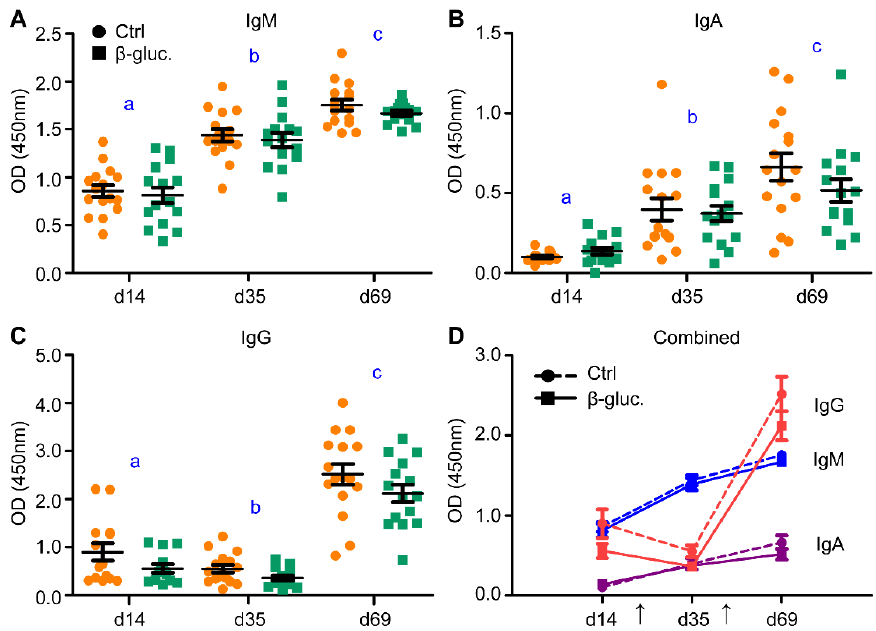
Figure 6. Levels of vaccine-specific IgM ( A ), IgA ( B ) and IgG ( C ) were measured in blood serum prior to vaccination (day 14), three weeks after vaccination (day 35) and 3 weeks after the booster vaccination (day 69). ( D ) incorporates the results of ( A – C ). The arrows in plot ( D ) indicate the time of vaccine (Salmoporc ® ) administration (d21 and d45). From every pen, two control animals (circles; ●, dashed lines) or two β-glucan treated animals (squares; ■ , solid lines) were randomly selected and followed over time ( n = 16 per treatment group). Every symbol represents a single observation. No significant differences were observed between the treatment groups. Letters (a, b, c) represent